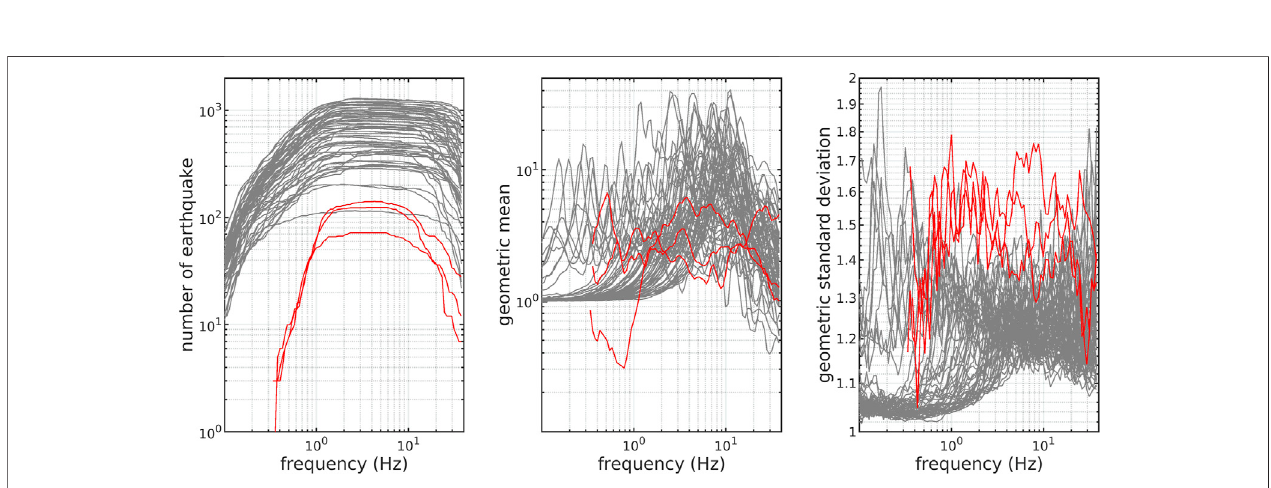
FIGURE 4 | Number of good-quality earthquakes (left panel), within-site geometric mean (central panel), and within-site geometric standard deviation (right panel) as a function of frequency for 60 surface-to-borehole spectral ratios in Japan (gray curves) and three standard spectral ratio in Switzerland (red curves).